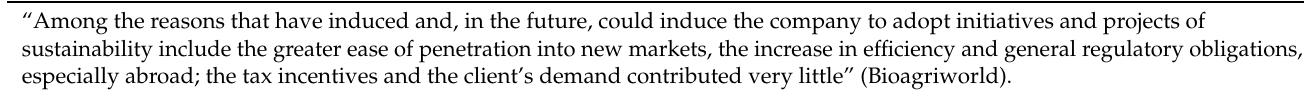
Table 2. Statements by the companies interviewed.